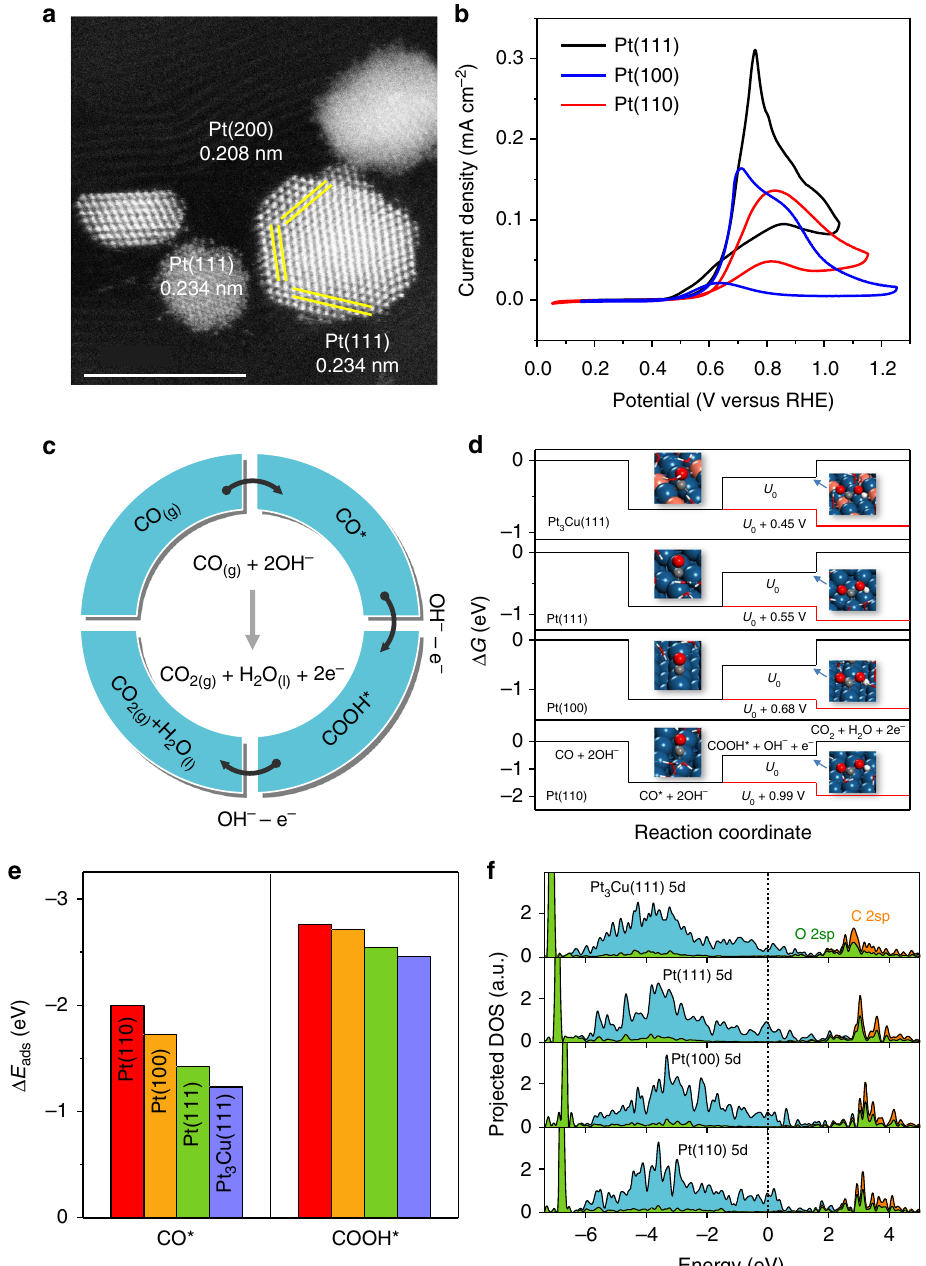
Fig. 3 Insights into the reaction mechanism of different Pt facets towards the EWGS. a HAADF-STEM image of Pt@CNTs, scale bar: 5 nm. b CV test of Pt (111), Pt(110), and Pt(100) electrodes in CO-saturated 0.01 M KOH at 25 °C with a sweep rate of 50 mV s − 1 . c Reaction path of the EWGS process in alkaline solution. d Free energy diagrams of CO oxidation on Pt(110), Pt(100), Pt(111), and Pt 3 Cu(111) at the reversible potential ( U 0 ) of − 0.16 V, and at the overpotentials that all reaction steps are downhill in free energy. e , f Comparison of the adsorption energies ( Δ E ads ) of CO and COOH and projected density of states of CO on Pt(110), Pt(100), Pt(111), and Pt 3 Cu(111) in water